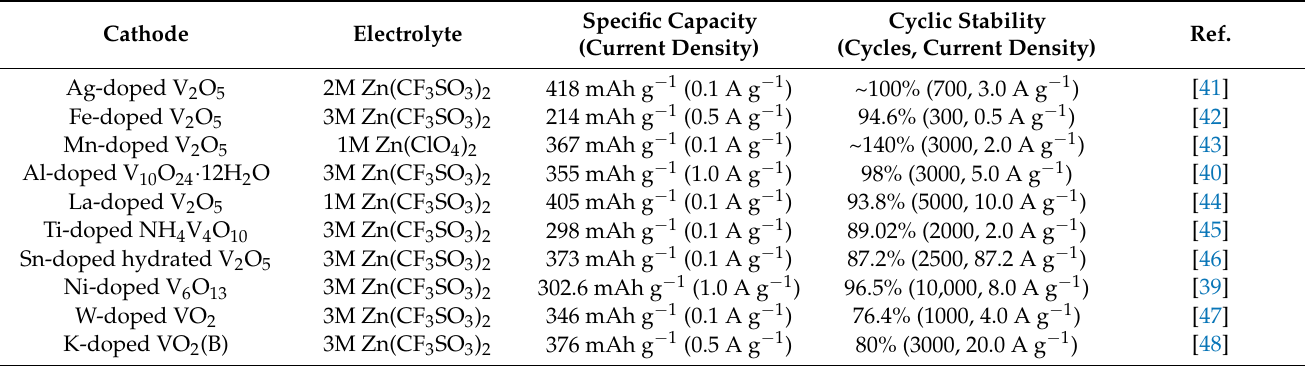
Table 2. Performance comparison of vanadium oxide-based materials doped with different metal ions. Specific Capacity Cyclic Stability Cathode (Current Density) (Cycles, Current Density)